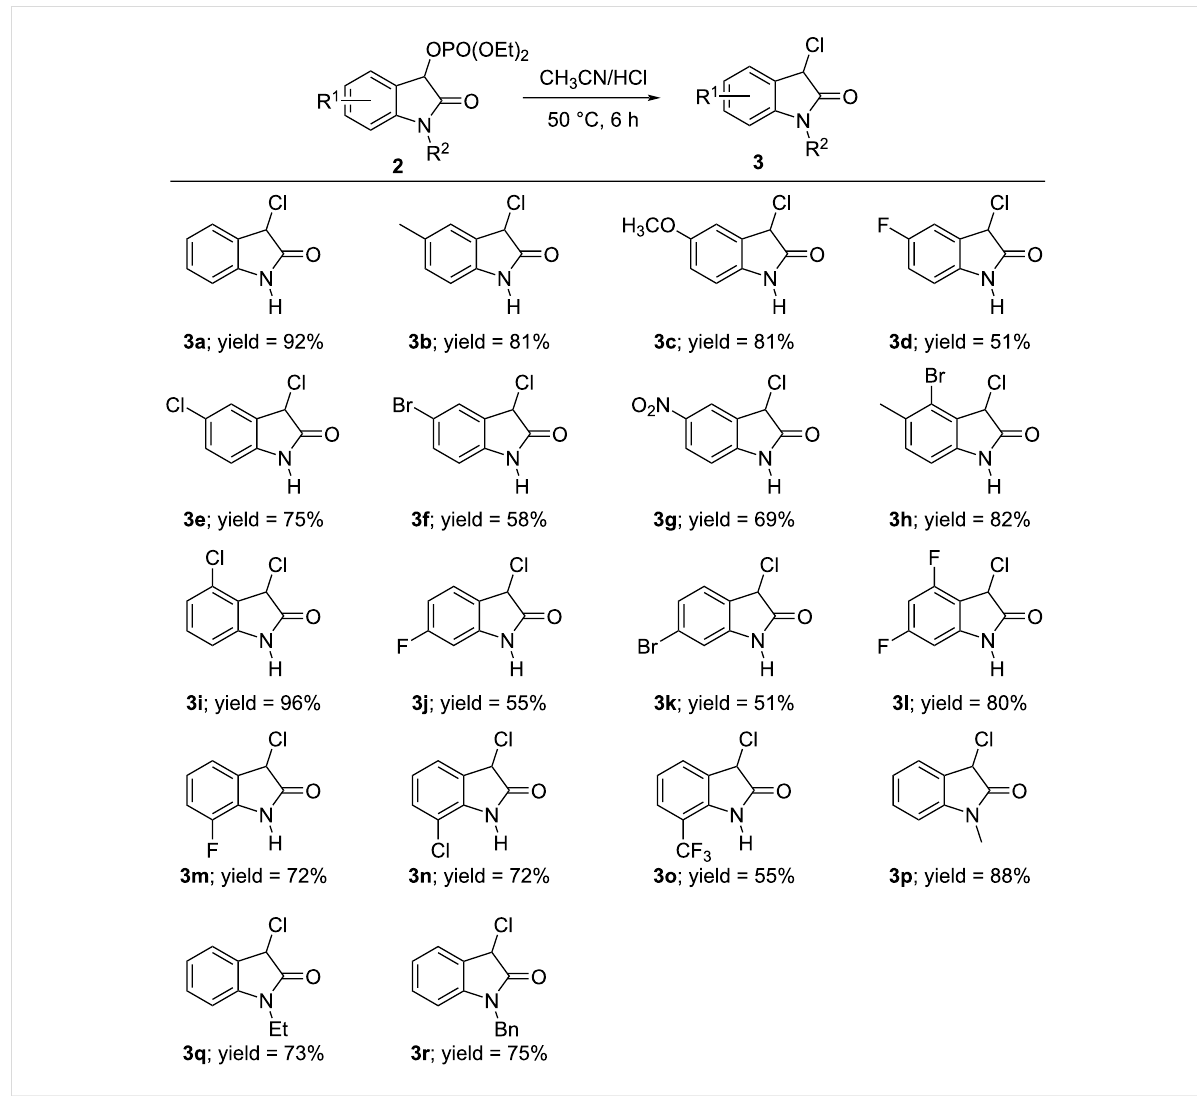
Scheme 2: Substrate scope of the acidolysis of isatin-derived phosphates 2 with hydrochloric acid. Standard reaction conditions: 2a–r (0.5 mmol), re- spectively, hydrochloric acid (7.5 mmol, 15 equiv), CH 3 CN (3 mL), 50 °C, 6 h. The isolated yields are